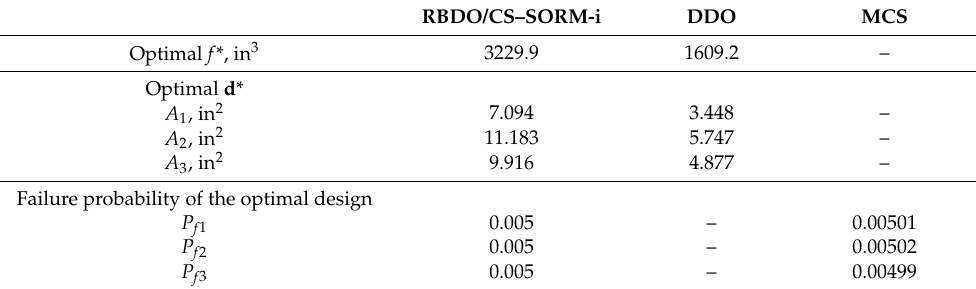
Table 5. Results of the RBDO/CS–SORM-i framework and DDO for the three-bar Table 3. Description of the random variables for the truss problem. Random